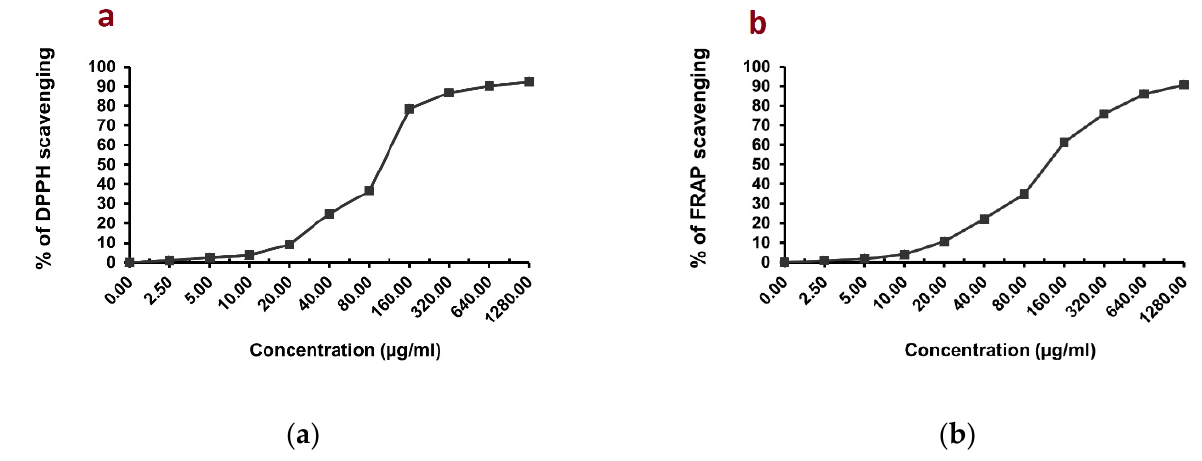
Figure 1. ( a ) The scavenging rate (%) of DPPH and ( b ) the scavenging rate (%) of FRAP by C. endivia L. crude extract. All values in the figure are expressed as means (%) and SD of triplicated experiments.